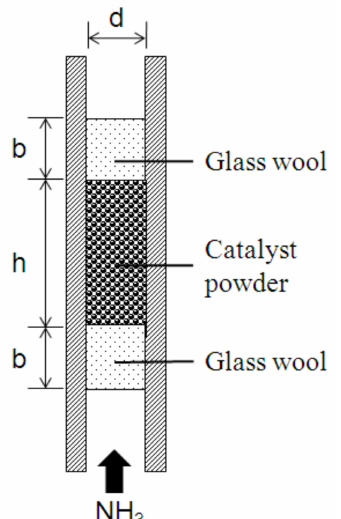
Figure 9. The cross-section of the tubular fixed-bed